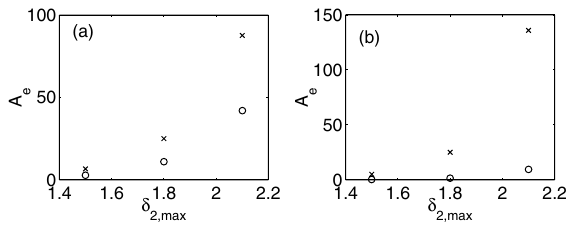
FIG. 5. Electron amplification factor for the secondary yield. The crosses and circles denote the peak and bottom values, respectively. (a) and (b) are for 3 GeV injection and for 50 GeV injection at J-PARC, respectively.